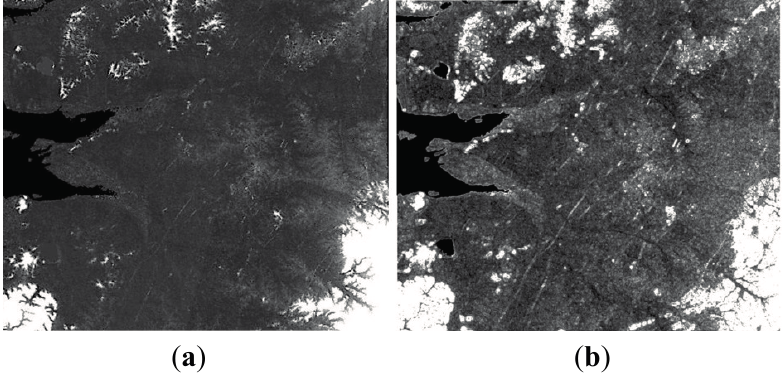
Figure 3. Terrain information: ( a ) DEM; ( b ) DSM.